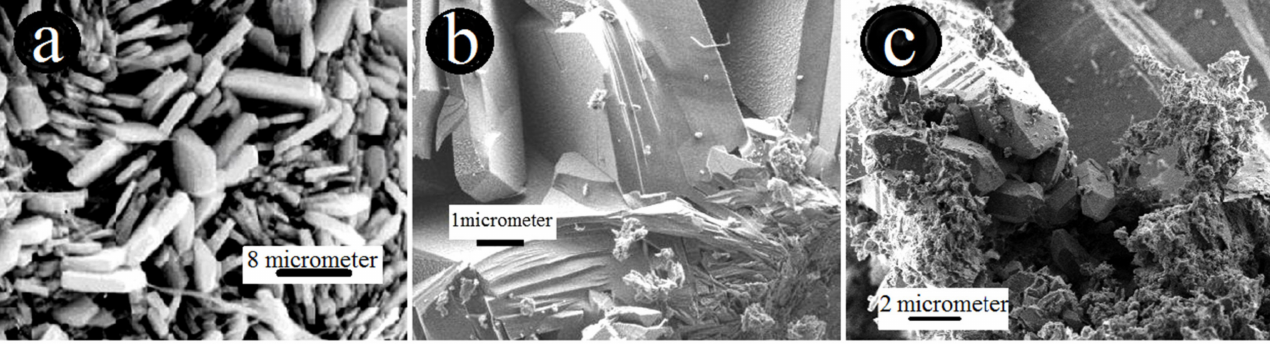
Figure 3. Surface morphology under SEM of natural zeolite-clinoptilolite ( a ), FeO(OH)-MnOx-zeolite, ( b ) and MnOx- zeolite ( c